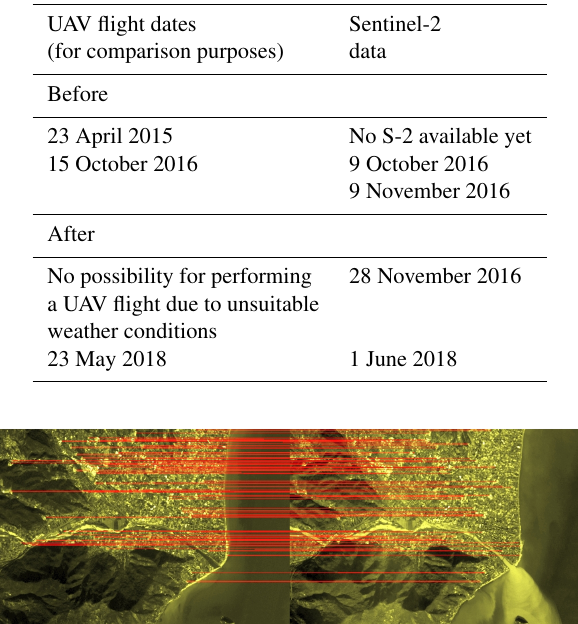
Table 1. Dataset used: Sentinel-2 (S-2) data of Copernicus pro- gramme.